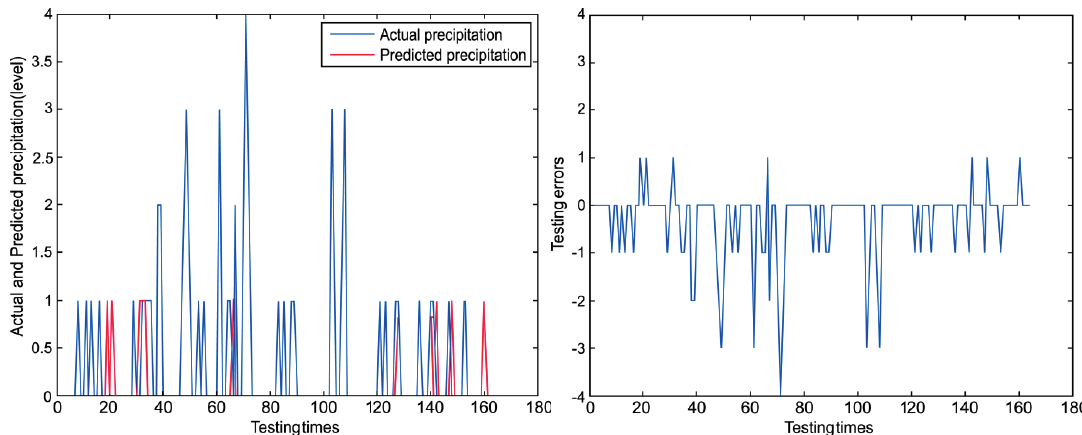
Figure 7. Testing results of NFIS-WPM (High-prob).